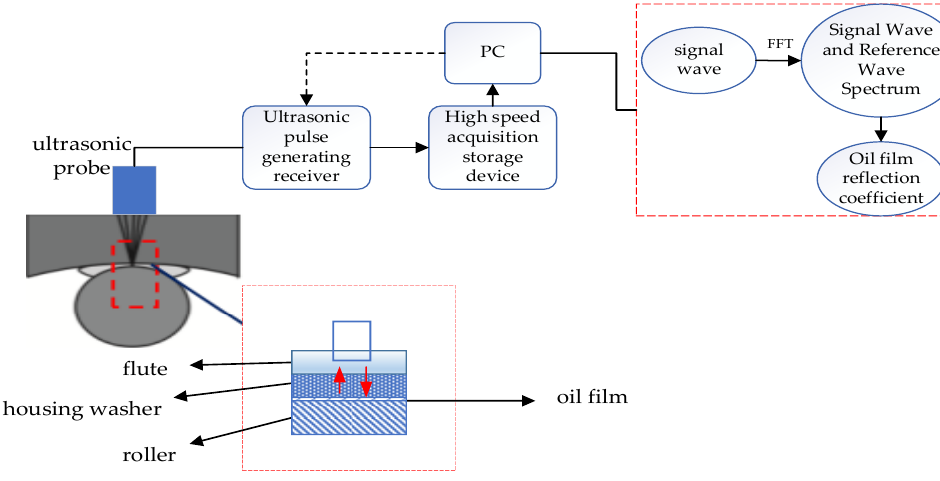
Figure 11. Ultrasonic measurement of roller bearing film thickness principle.